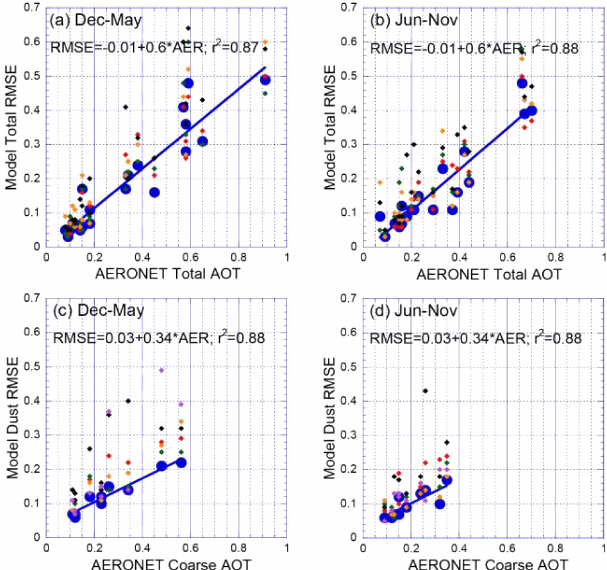
Figure 8. Same as Fig. 7 for total and dust AOT, with + 4-day RM-